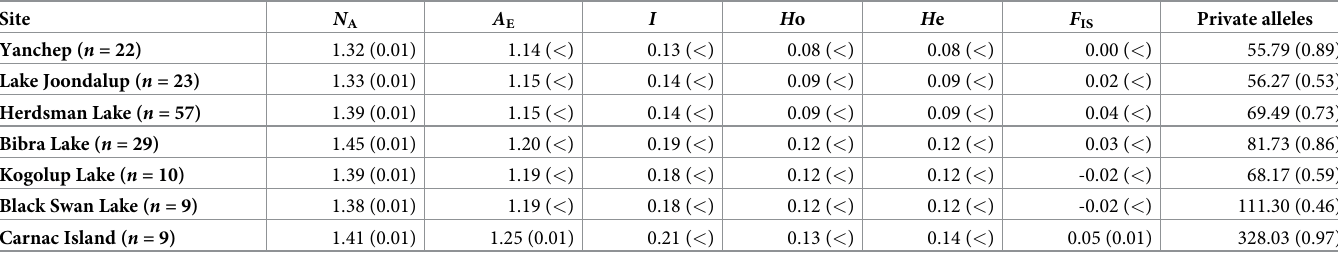
Table 2. Genetic diversity estimates of seven populations of Notechis scutatus occidentalis around Perth, Western Australia. Site